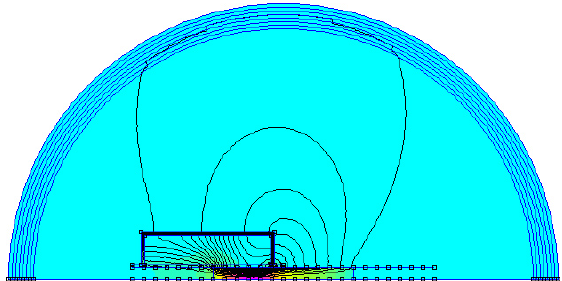
Figure 4. FEMM 4.2 model: flux density.